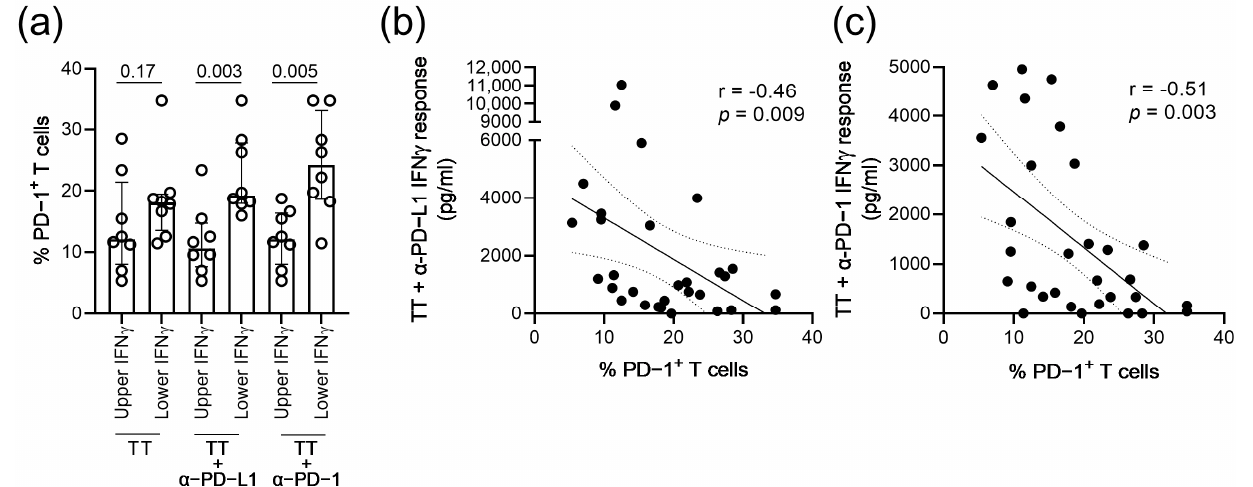
Figure 3. Correlation between the blood CD4 T cell levels and T cell PD-1 expression levels. ( a ) Linear regression analysis with percentages of CD4 T cells. ( b ) Linear regression analysis with CD4 T cell counts (cells/ µ L). The 95% confidence interval of linear regression, as well as the rhos and p -values of the Spearman correlations, are presented.